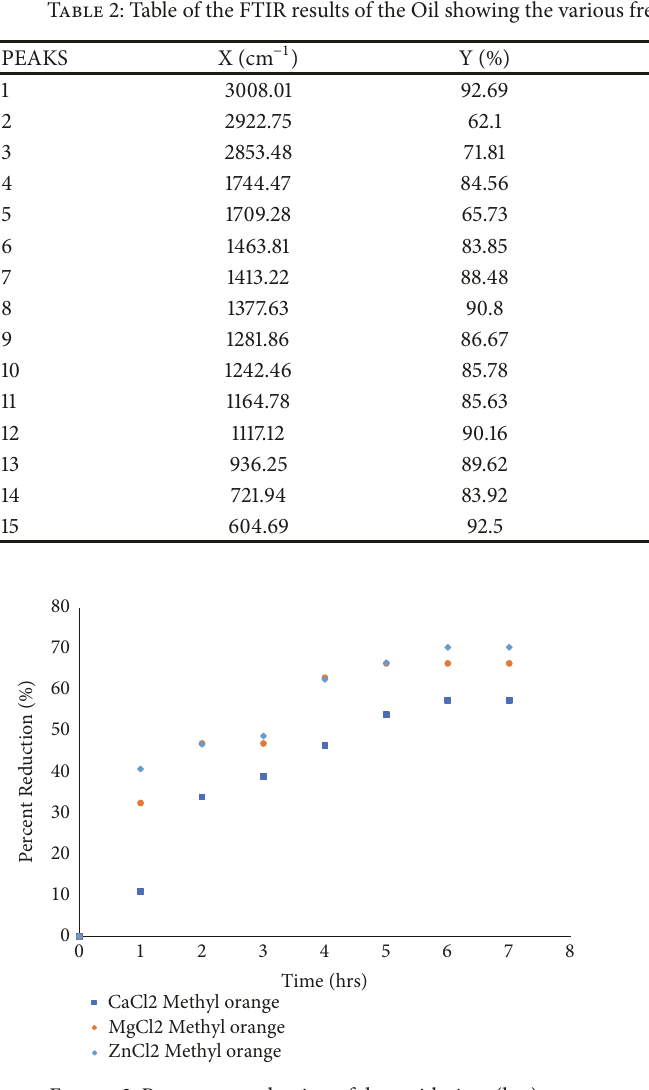
Figure 3: Pseudo-first-order adsorption kinetics of the